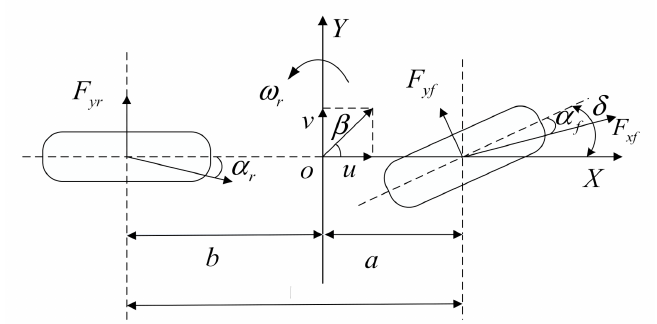
Figure 3. Two-degrees-of-freedom vehicle dynamic